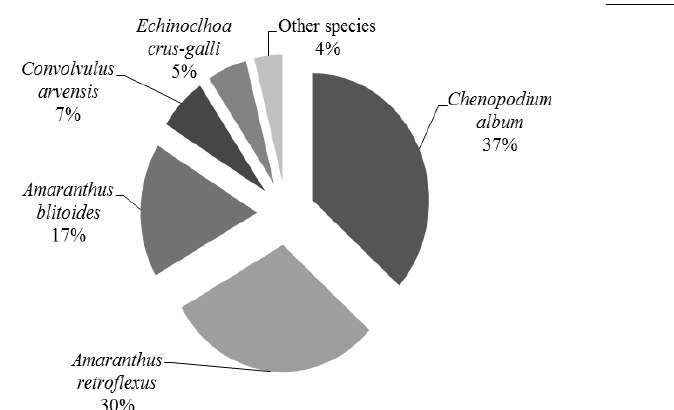
Fig. 2. The effects of duration increase of weed-infested (empty squares) and weed-free (squares) periods on weed biomass. Equations for fitted curves are given in Table